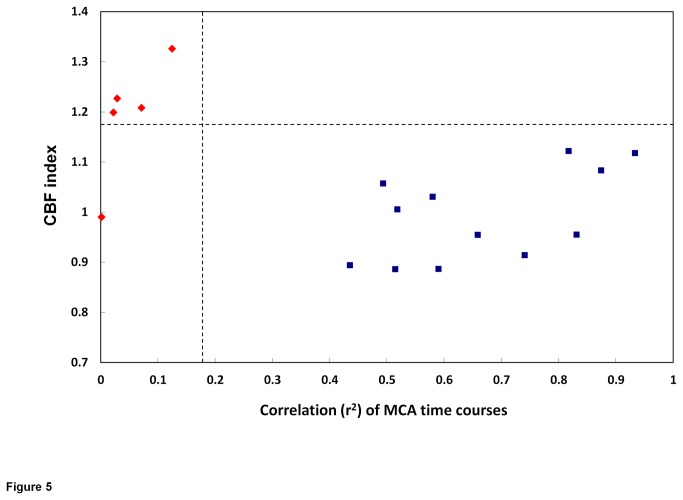
The scatter plot of CBF index of lesion side versus correlation (r2) of the ipsilateral and contralateral MCA time courses from the 17 patients.Red dots represent patients with r2<0.18 (t-value<2.1, p>0.05). Four of these five patients have greater CBF index than the patients with r2>0.18 (t-value≥2.1, p<0.05) by one standard deviation (CBF index>1.17).